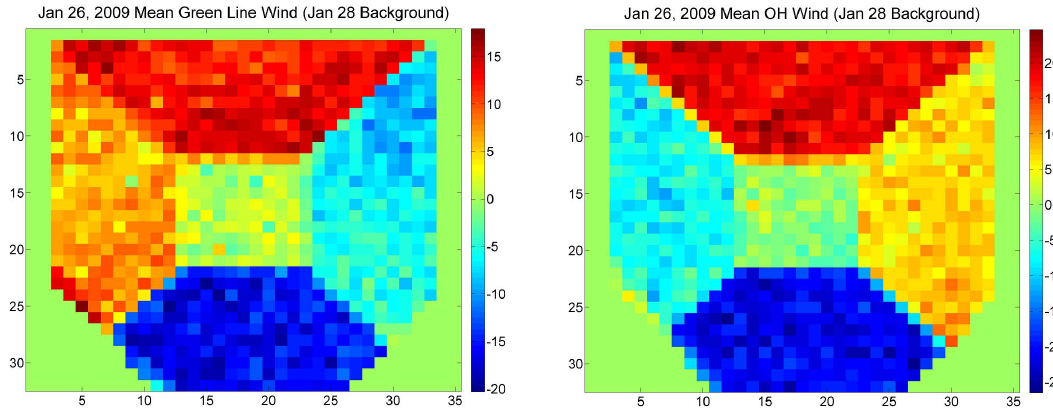
Fig. 4. An image of the daily averaged wind image (ms − 1 ) for the green-line and OH observations on 26 January 2009, using the 28 Jan- uary 2009 phase average for the background phase. The averages are calculated on a bin-by-bin basis. The sector averages of these images provide the daily mean winds in each direction. The uniformity of each sector and the fact that opposite sectors are of similar magnitude but opposite sign indicates that the phase background is not introducing systematic errors into the wind